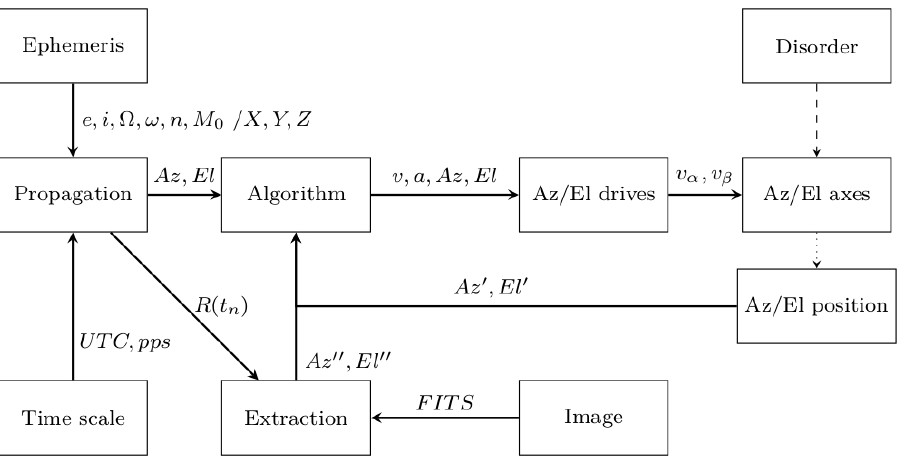
Figure 6. Block diagram of the active control correction algorithm based on ephemeris data and image